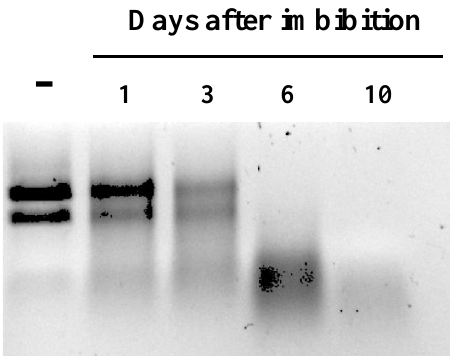
Figure 2. Ribonuclease activity in common bean during cotyledon development. Ribonuclease activity was determined in crude extracts obtained from cotyledons at the indicated days after start of imbibition (DAI) using 1 µg of total RNA isolated from common bean radicles as substrates and equal amounts of total soluble protein in crude extracts. As control, the total RNA used as substrate was incubated in the absence of crude extracts ( − ). After enzymatic reactions, the remaining rRNA was visualised in agarose gels after